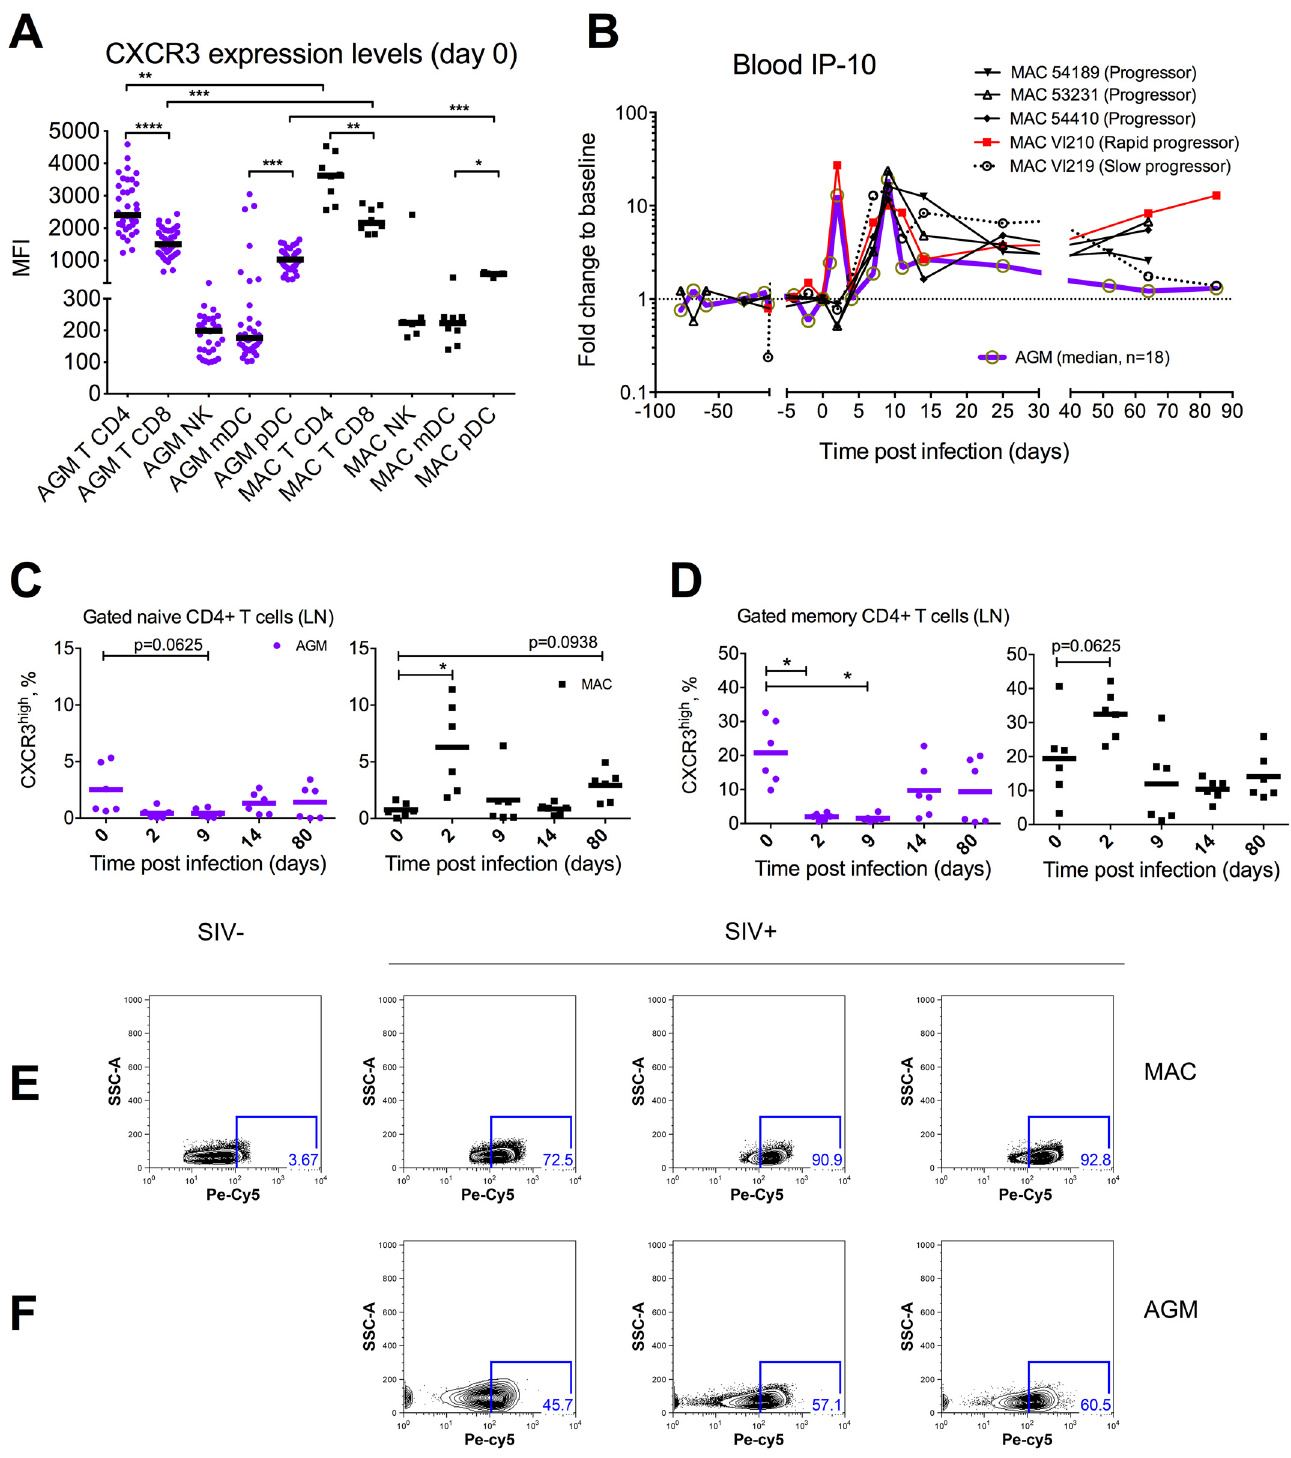
Fig 6. Dynamics of CXCR3+ T-cells and blood IP-10 levels during pathogenic and non-pathogenic SIV infections. A. CXCR3 expression levels as mean intensity of fluorescence (MIF) in rhesus macaques (n = 8) and AGM (n = 18) peripheral blood cell subsets before SIV inoculation. B. Blood IP-10 dynamics in 5 rhesus macaques versus AGMs (n = 18, median is shown here) IP-10 levels in plasma were determined in a longitudinal study, before infection and after SIVmac251 or SIVagm.sab92018 challenge in macaques or in AGMs, respectively. IP-10 values are expressed as the fold change from baseline (median of 3 to 4 values obtained before infection). (C-F). CXCR3 expression dynamics from SIVmac